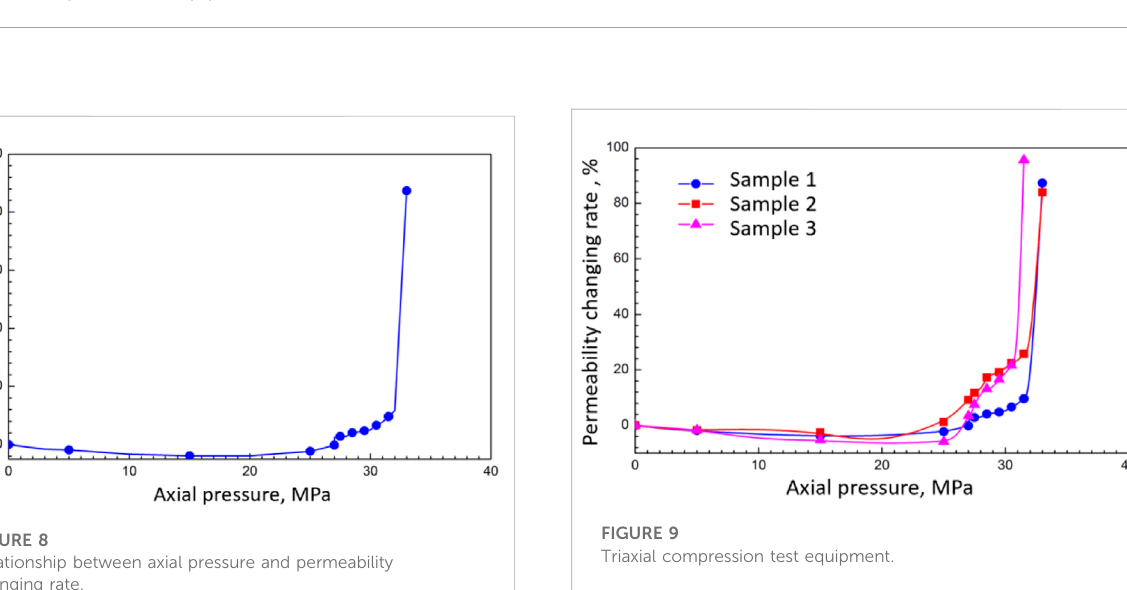
FIGURE 7 Triaxial compression test equipment.